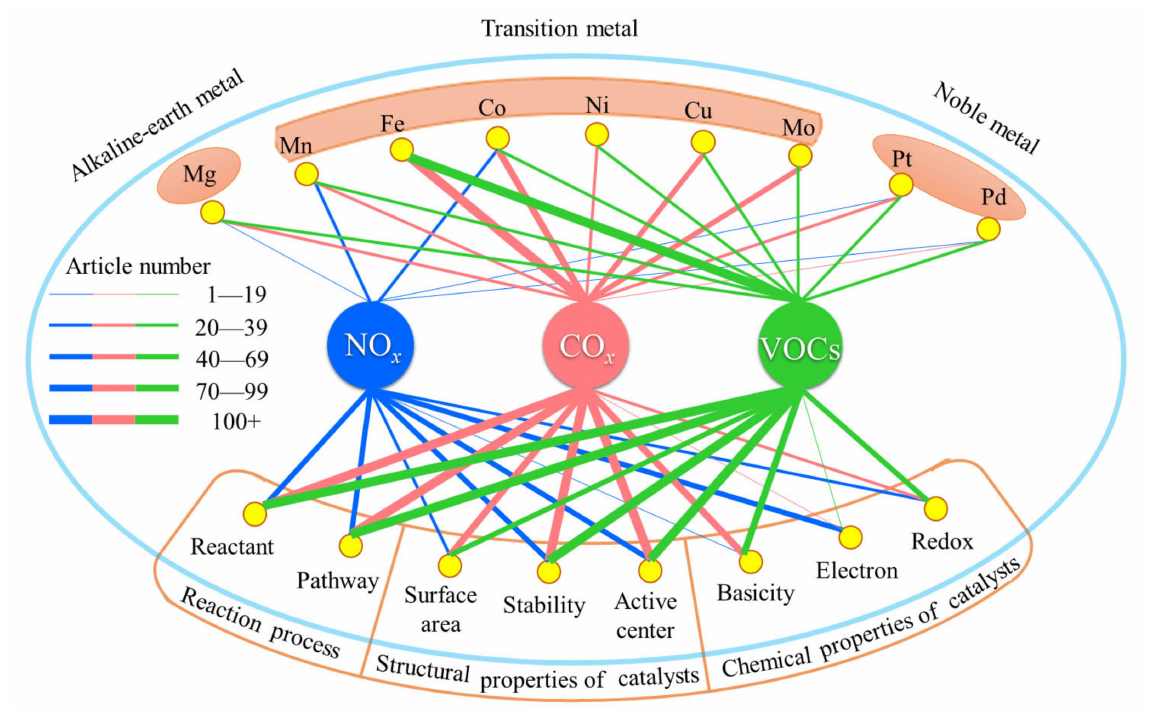
Figure 17. The correlation of the promotion effect of K on the commonly used active centers and types of promotion effect for NOx, COx, and VOCs.